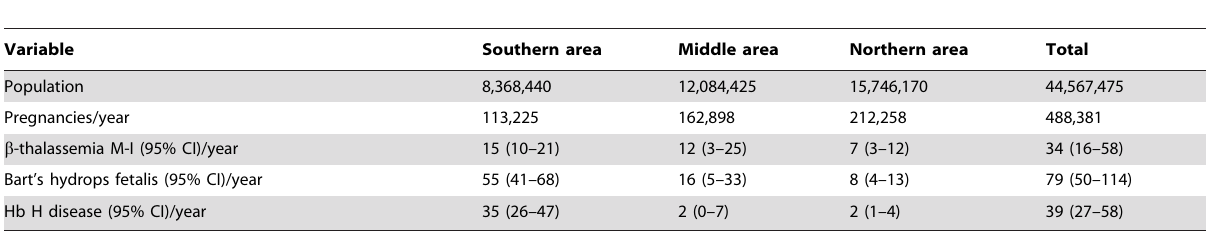
Table 3. The future health burden prediction in Jiangxi province.